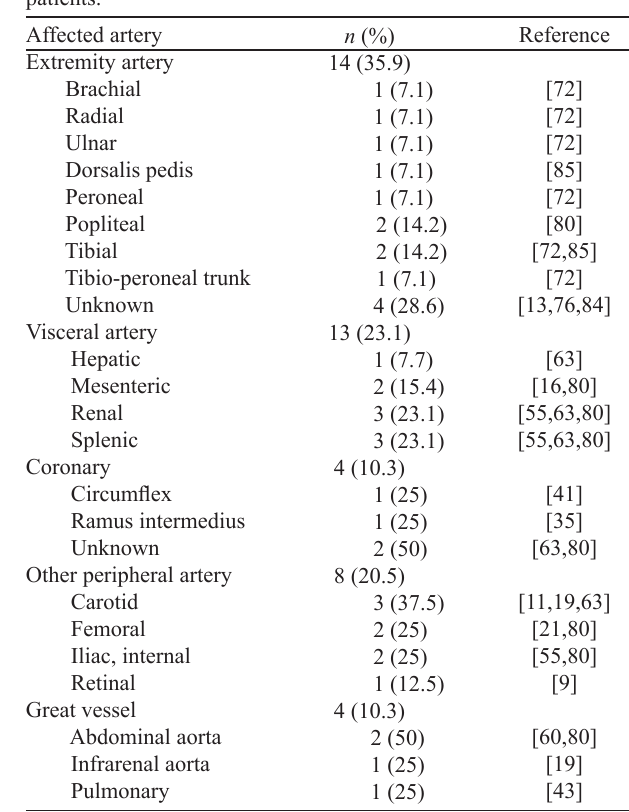
Table 8. The 39 affected arteries other than cerebral artery in 18